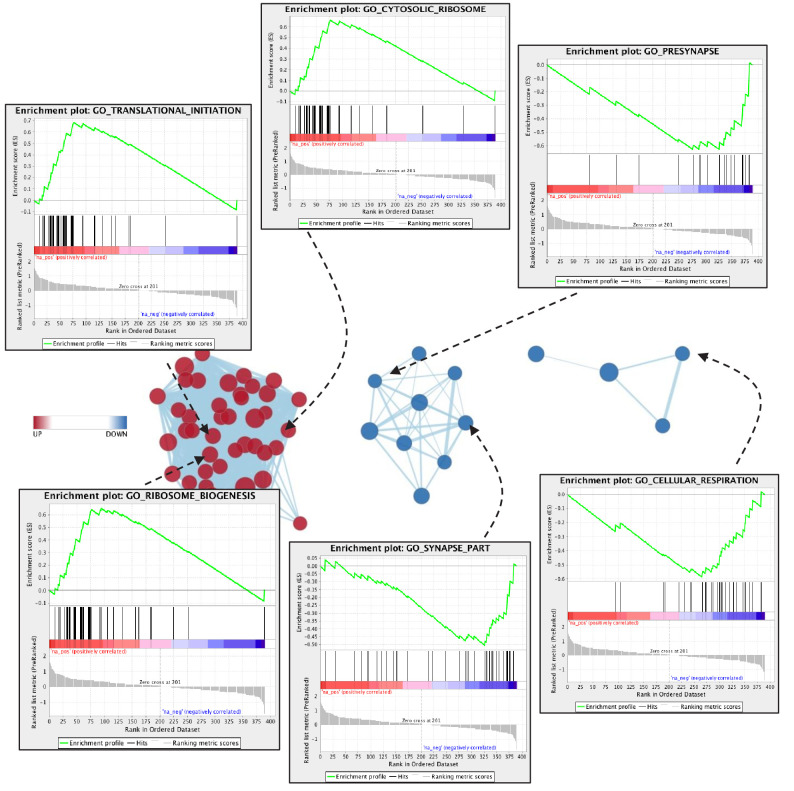
Examples of GO terms in each cluster are provided.Enrichment score (green line) is computed by individual protein rank (black vertical lines) in the ranked list for each GO term and direction of change (up vs. down vs. no change).